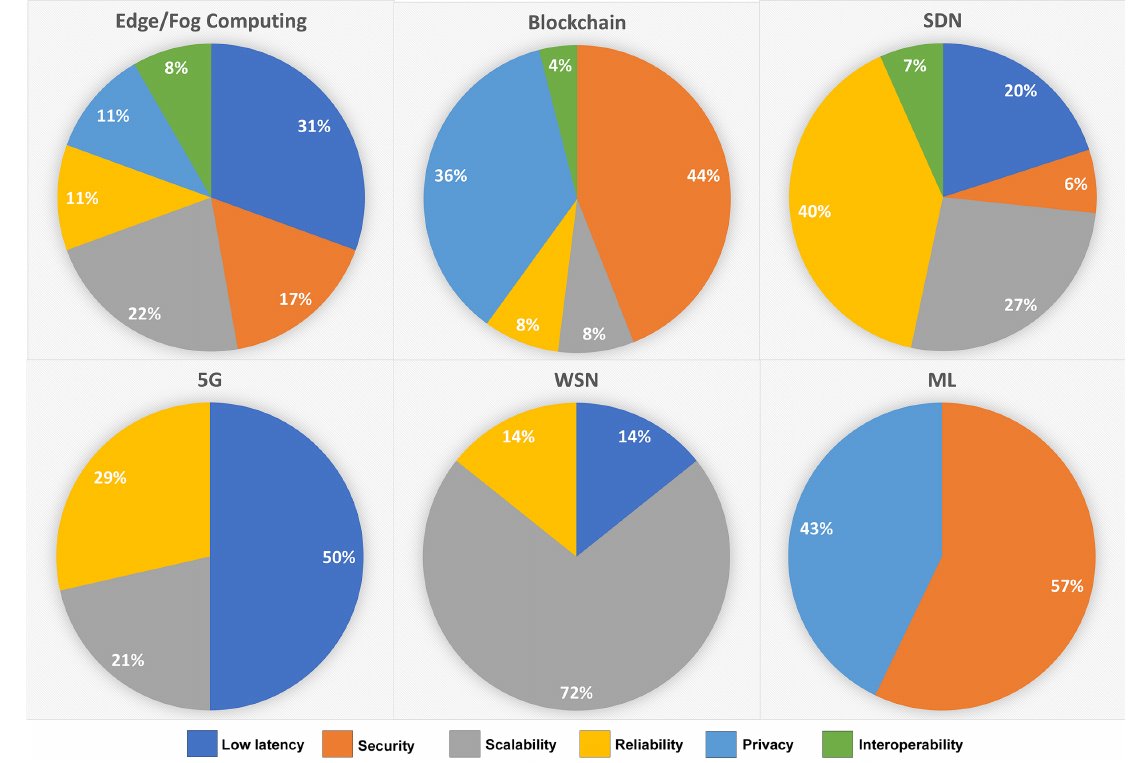
Figure 10. Relation between emerging technologies and key requirements in IIoT